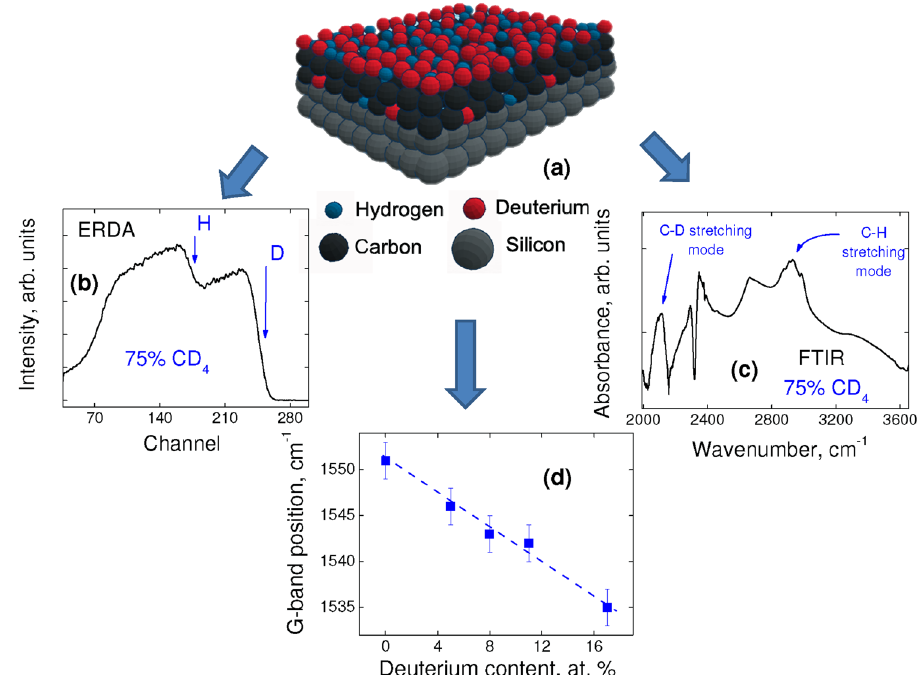
Figure 1. ( a ) Schematic of a typical a-C:D/H thin film deposited on a silicon substrate. ( b ) ERDA and ( c ) FTIR spectra obtained from the a-C:D/H thin film deposited with 75% of CD 4 in the gas mixture. ( d ) G-band